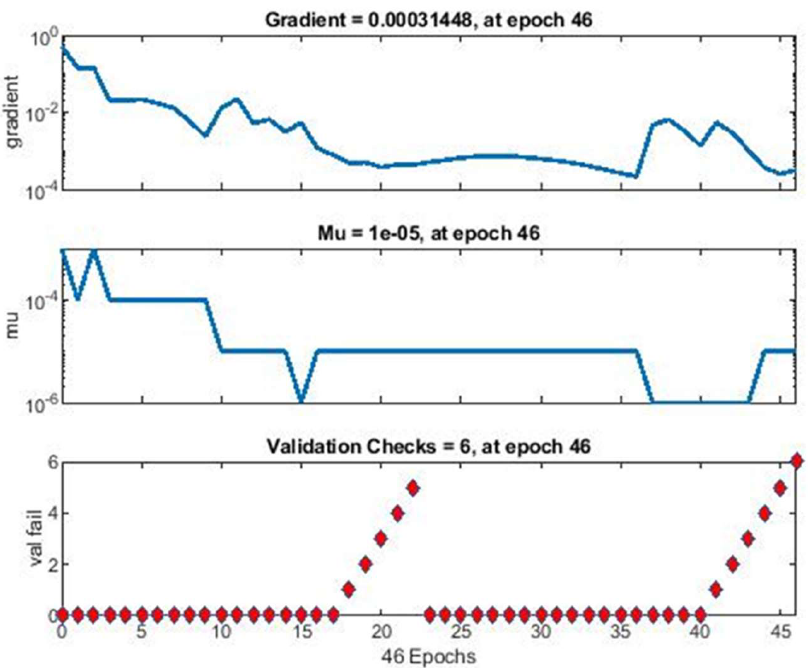
Figure 10. ANN results related to training phase.